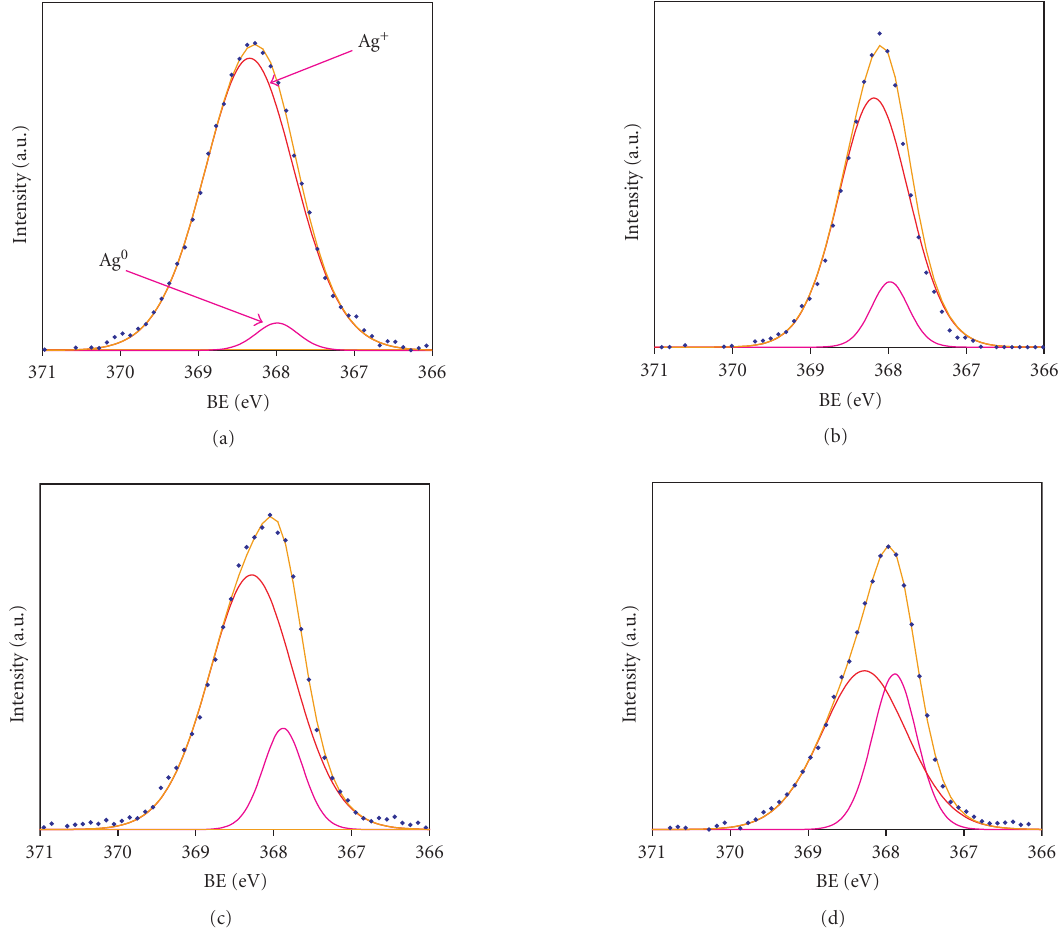
Figure 3: Fitted high-resolution XPS spectra of the Ag 3d 5 / 2 peaks for 1wt.% Ag-TiO 2 photocatalysts calcined at (a) 70 ◦ C, (b) 200 ◦ C, (c) 450 ◦ C, and (d) 600 ◦ C.